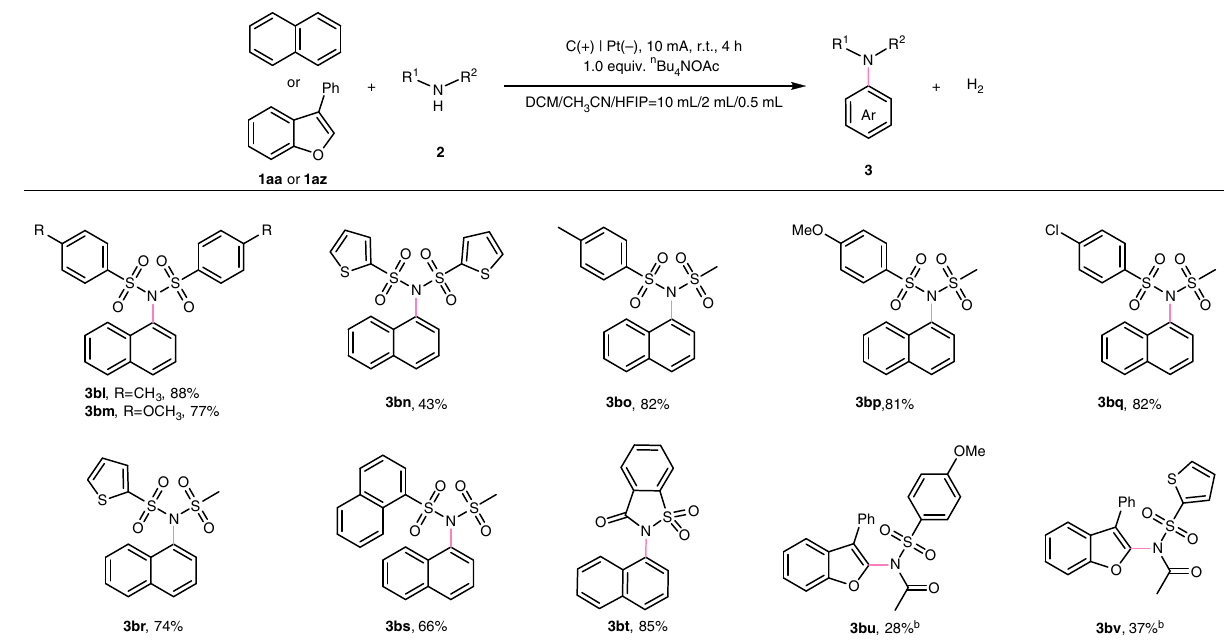
Fig. 3 Substrate scope of sulfonimides. Reaction conditions: carbon rod anode, platinum plate cathode, constant current = 10 mA, 1aa (0.40 mmol), 2 (0.60 mmol), n Bu 4 NOAc (0.40 mmol), solvent ((DCM/CH 3 CN/HFIP = 10 mL/2 mL/0.5 mL), undivided cell, N 2 , 4 h. Isolated yields. b Reaction conditions: carbon cloth anode, platinum plate cathode, constant current = 3 mA, 1az (0.40 mmol), 2 (0.60 mmol), n Bu 4 NBF 4 (0.40 mmol), NaOAc (0.8 mmol), solvent ((DCM/CH 3 CN/HFIP = 10 mL/2 mL/1 mL), undivided cell, N 2 , 8h.